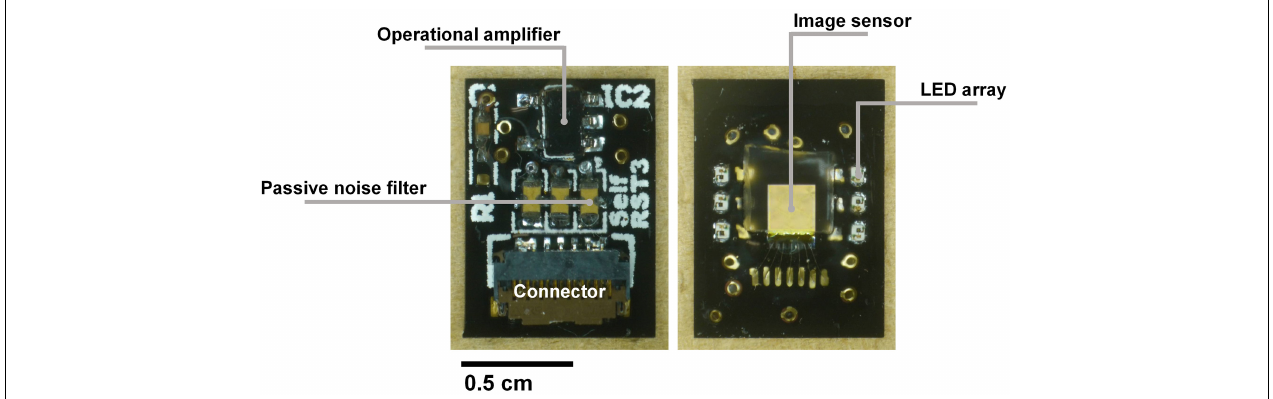
FIGURE 6 | Images of the relay board (left) with the preamplifier circuit and passive noise filters placed on this side. (Right) The image sensor is mounted between the LED arrays to benefit from the high light intensity. The image sensor surface was covered by the fiber optic plate and sealed with epoxy resin for waterproofing.